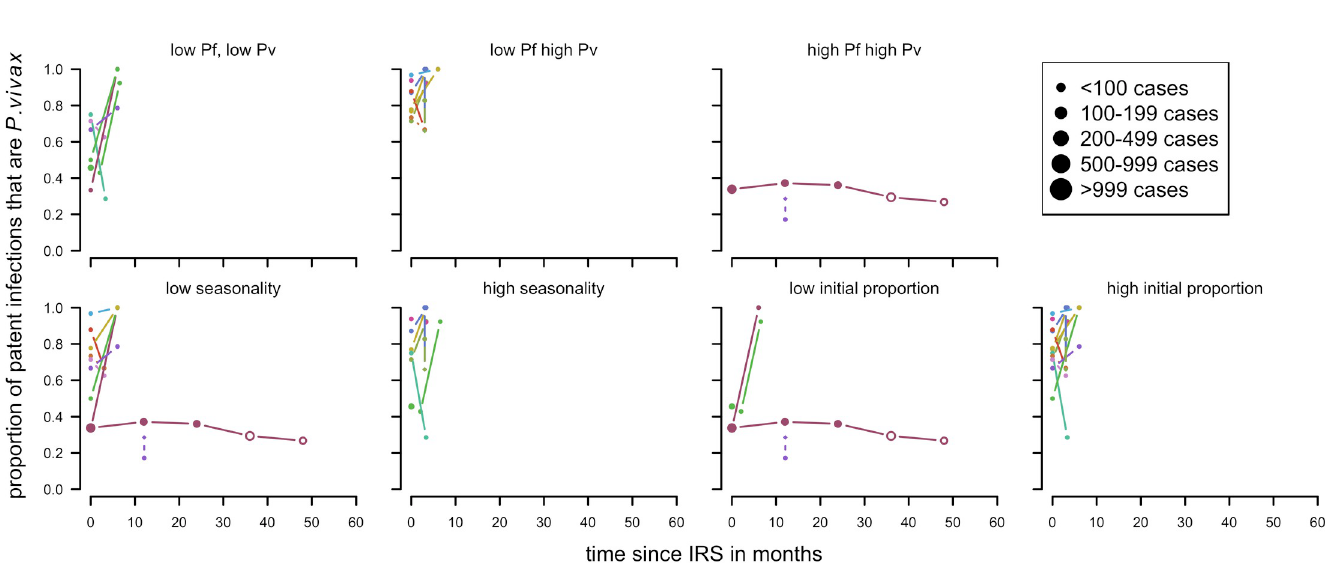
Fig 18. Spaghetti plots splitting the series of time-points of the proportion of patent infections that are P. vivax by seasonality, initial proportion of P. vivax and transmission intensity after IRS. Dot size depending on number of infections.